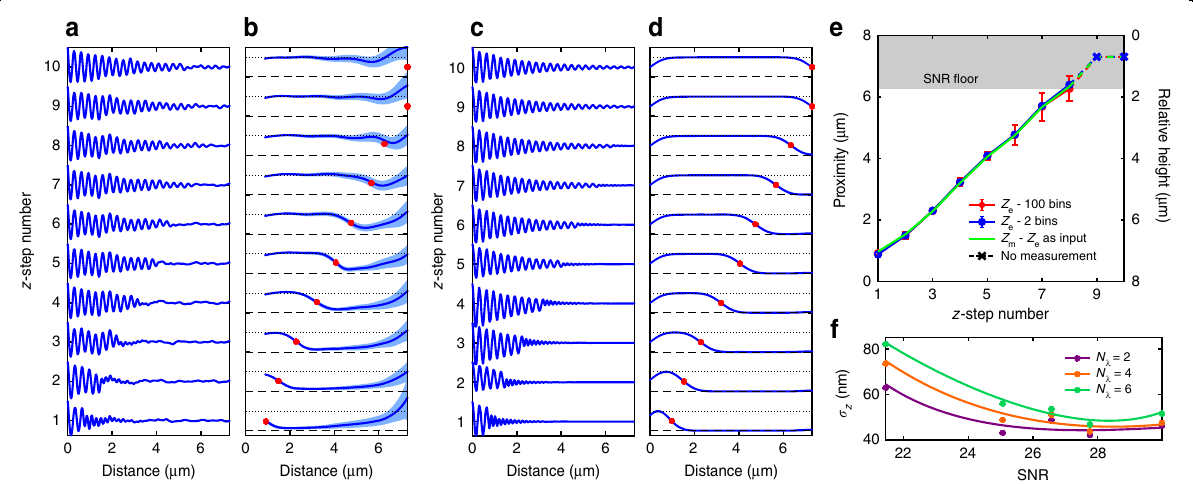
Fig. 3 Calibrating the in-depth measurement performance of the phonon probe. a TRBS signals as the phonon probe is incrementally stepped away from a PS boundary (vertically offset for clarity). b Normalised wavelet coef fi cient traces at each step, light blue shading represents standard deviation of time-varying amplitude. Red dots mark the proximity measurement (from z = 0), and are anchored to the end of the trace when a threshold is not met. Black dashed line is C w ″ = 0 and dotted line is C w ″ = 1. c , d Simulated TRBS and wavelet coef fi cient signals using the measurements in b as input water layer thicknesses. e Comparison of experimental ( z e ) and simulated ( z m ) proximity measurements showing the increase in precision with signal averaging (e.g. from 100 to 2 bins), yet a decrease in precision with distance. Proximity can be converted to height using a physical fl oor measurement or relative to the SNR fl oor. f Precision of a proximity measurement ( σ z ) as a function of SNR and the number of phonon wavelengths contained by the wavelet ( N λ